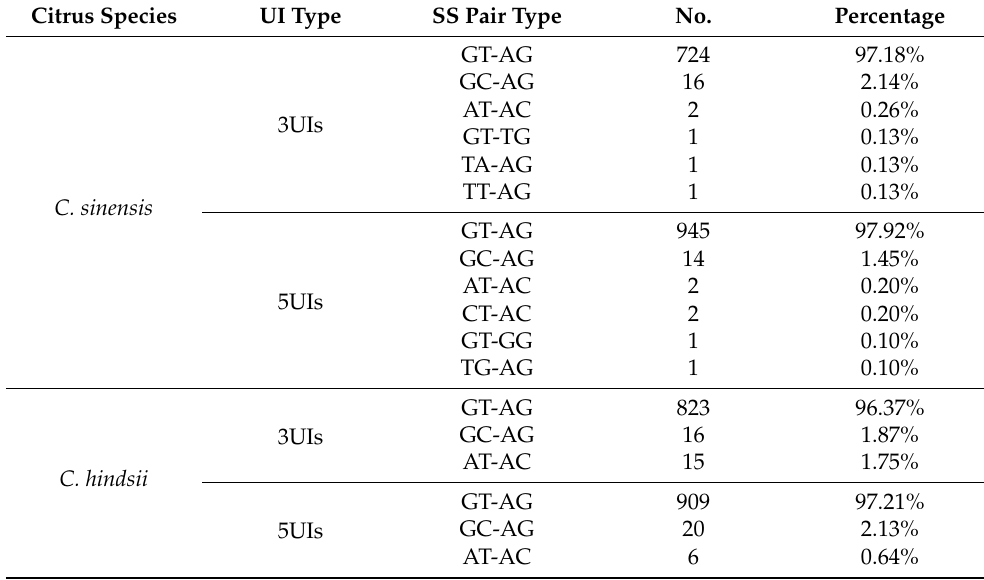
Table 3. Information for the splice site (SS) pair types of UIs in six citrus species. Citrus